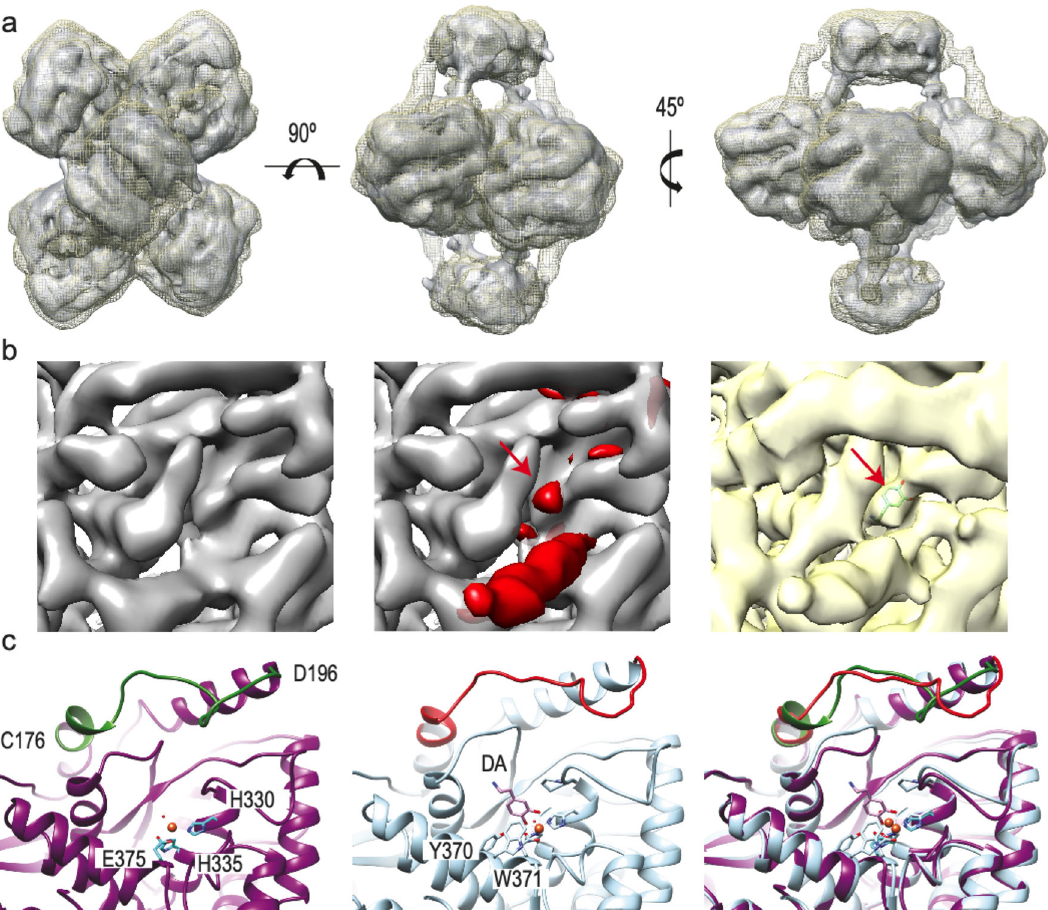
Fig. 3 Structural comparison of apo-TH and TH(DA). a Three orthogonal views of the Cryo-EM maps of apo-TH (grey) and TH(DA) (yellow, mesh) showing the extra density connecting the RD with the CD active sites. b The same, detailed view of the active sites of (left) apo-TH, (middle) a difference map of TH(DA) minus apo-TH (red) superimposed into the apo-TH map. The red cylinder shows the internalized α -helix and the mass representing DA (red arrow). Other small masses come from changes between both conformations. The contour level is set to 3 σ . The right panel shows the fi tting of the atomic structure of DA into the corresponding density. c The same, detailed view of the atomic model of the apo-TH active site (left) highlighting the segment encompassing residues 176 – 196 (dark green) and those involved in iron coordination (H330, H335 and E375). In the middle, the same view of the atomic model of TH(DA) with the 176 – 196 segment highlighted in red. Y370, which is in the BH4 binding pocket and forms an H-bond with the bound DA, is also modelled, and the 39 – 58 α -helix has been removed for convenience. The right image is a superposition of the two previous images, revealing the different arrangement surrounding the active